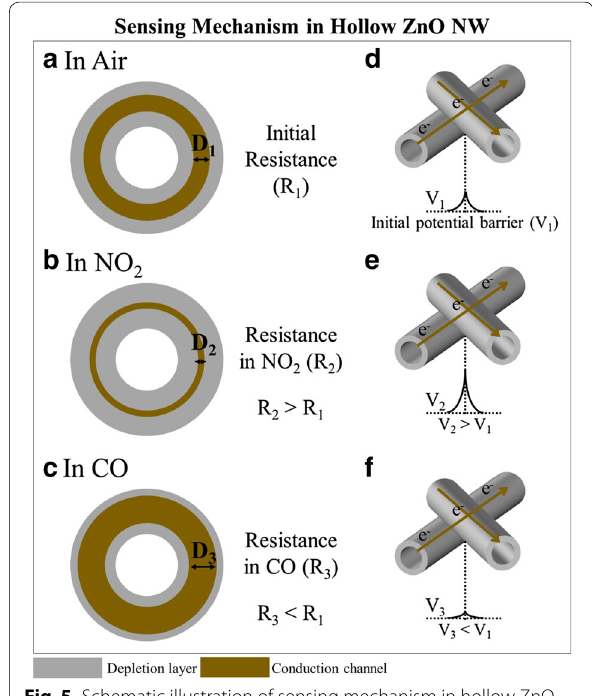
Fig. 5 Schematic illustration of sensing mechanism in hollow ZnO NWs. Changes in depletion layers in a air, b NO 2 , and c CO. Changes in potential barriers in d air, e NO 2 , and f CO